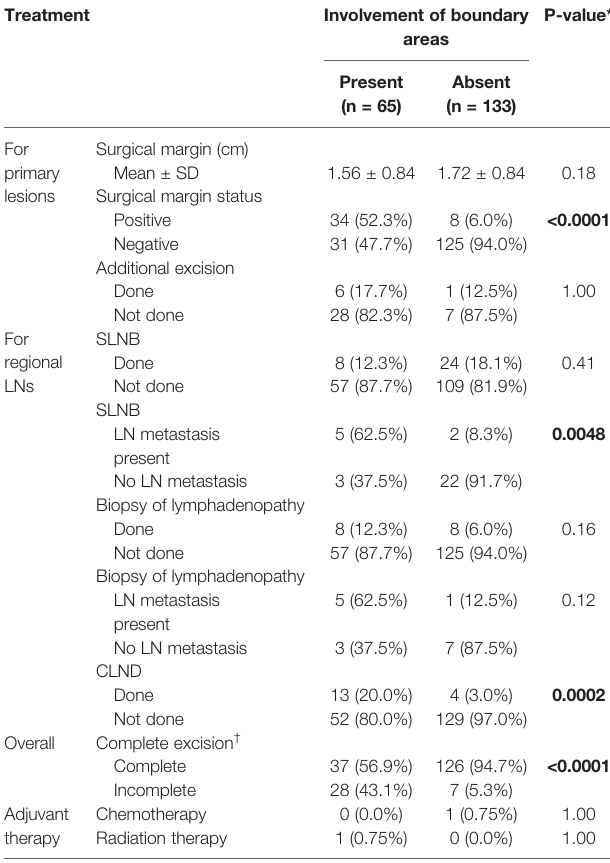
TABLE 3 | Initial treatment of the 198 patients treated with curative surgery. Treatment Involvement of boundary